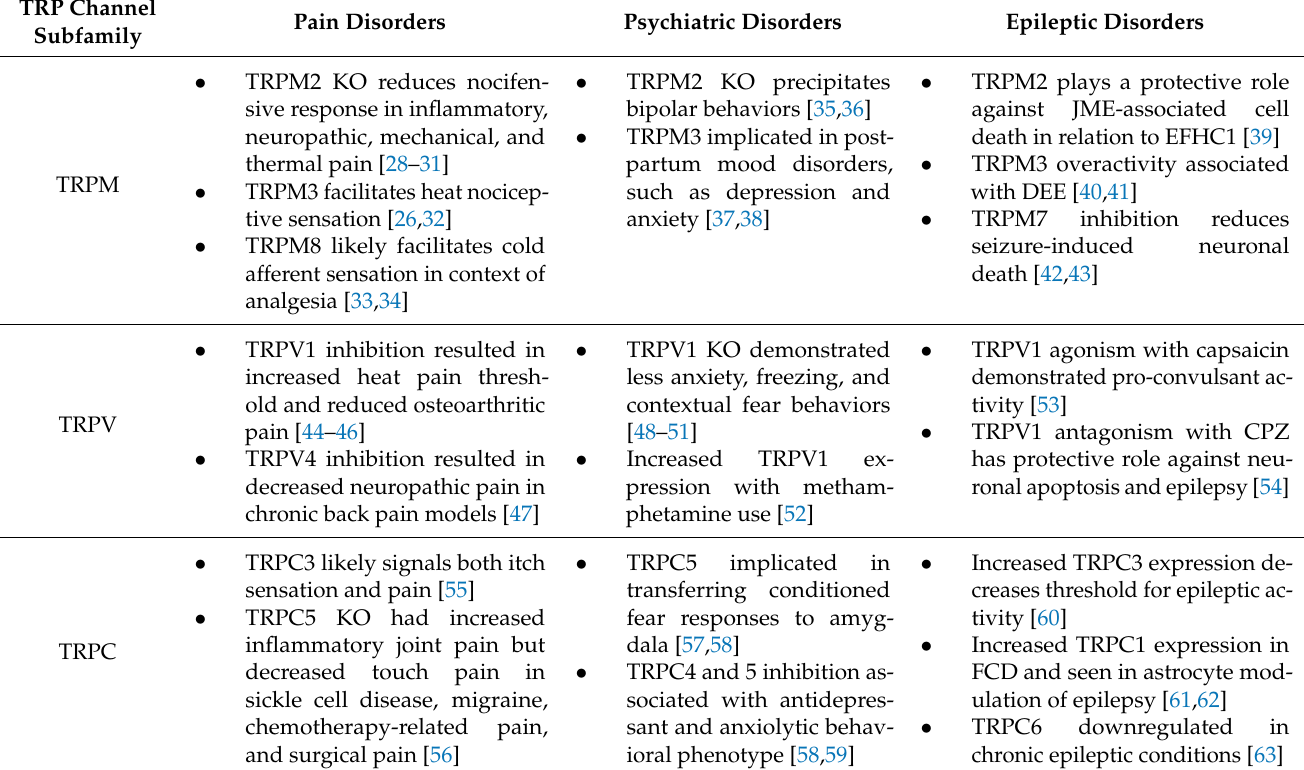
Table 1. TRP Channel subfamily is involved in pain, psychiatric, and epileptic